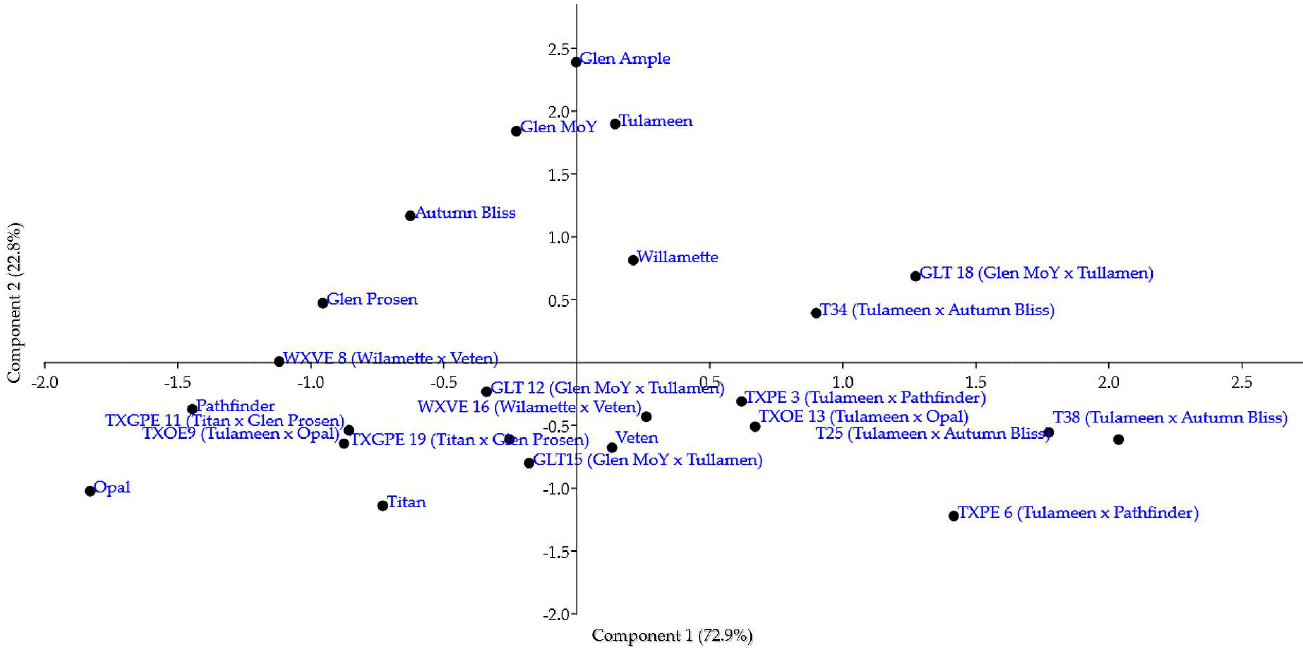
Figure 3. Principal component analysis (PCA) plot: the multivariate analysis performed for 24 rasp- berry genotypes (14 promising selections (clones), their parents, and Glen Ample cultivar as control) based on analyzed characteristics.